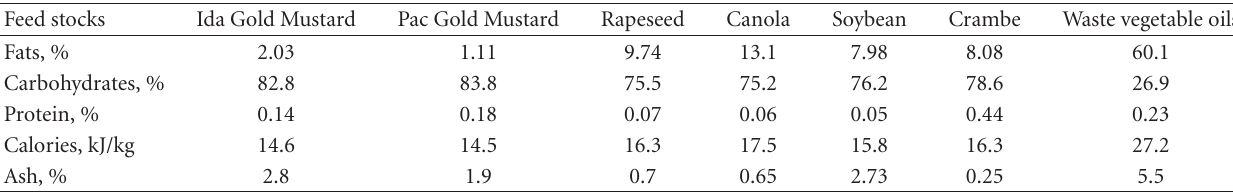
Table 2: Food nutrient analysis for crude glycerol samples